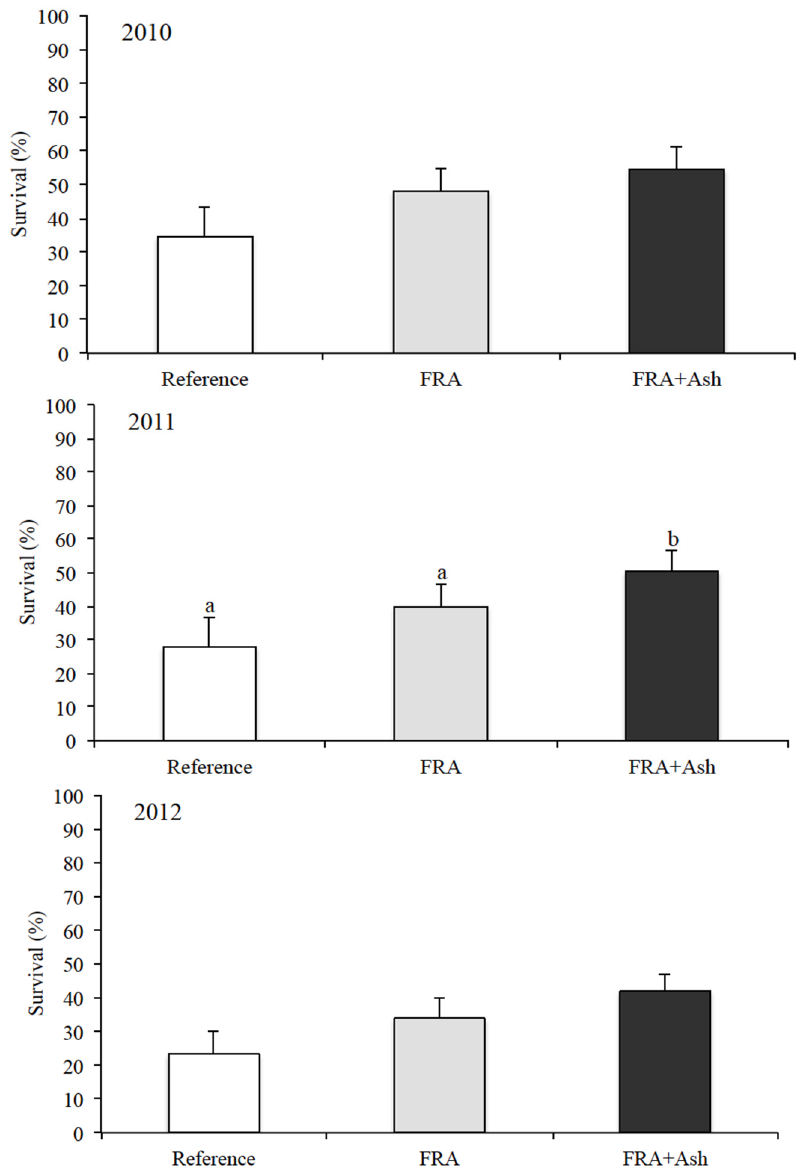
Figure 2. Mean survival with standard error after the first (2010), second (2011) and